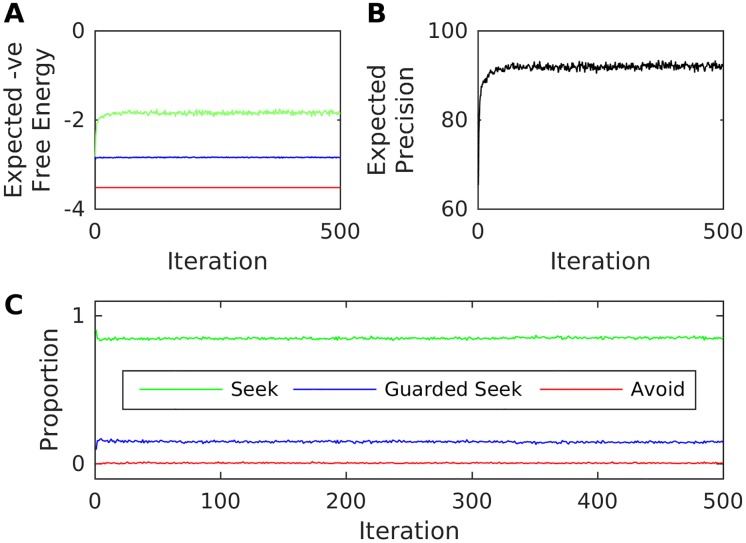
Secure attachment as free energy minimisation over interoceptive observations.The figure illustrates the emergence of secure attachment for an infant paired with a high-q (responsive) caregiver. A: Mean (over repetitions) expected negative free-energies for the three actions on the final step of each iteration. B: Mean (over repetitions) expected precision on the final-step of each episode. C: Mean (over repetitions) proportion each action was chosen over all iterations.